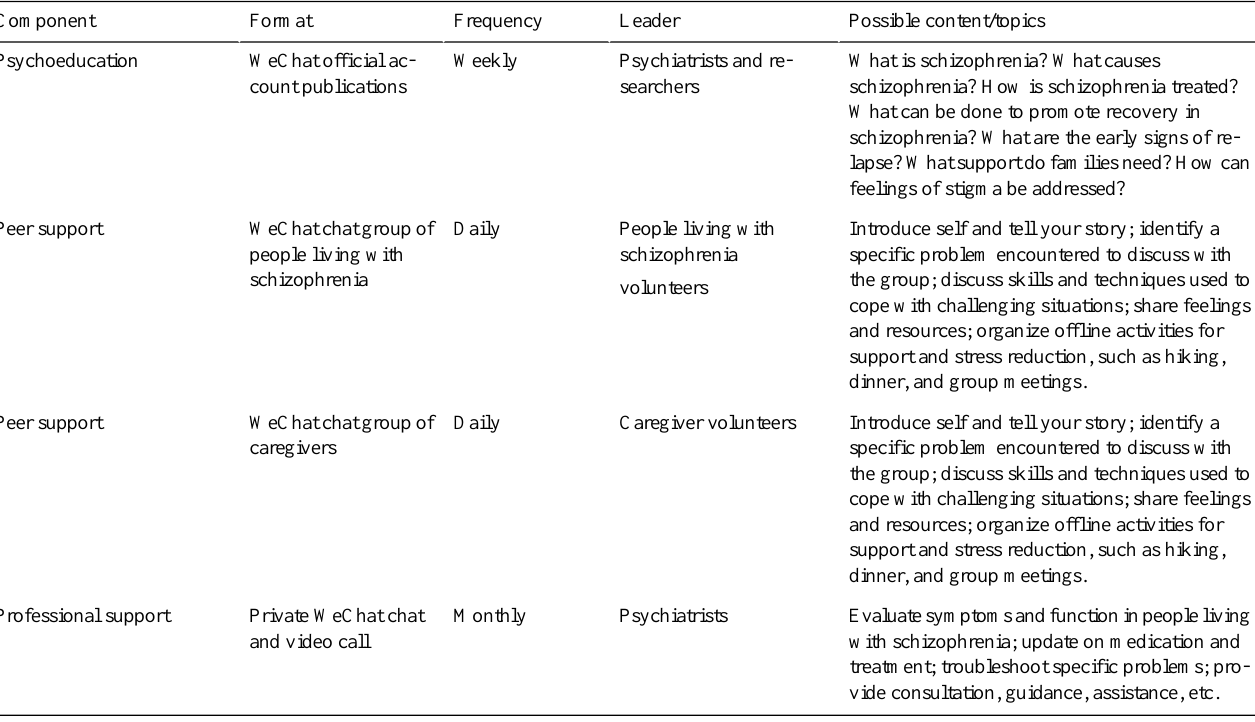
Table 2. Content of the WeChat-based integrative family intervention